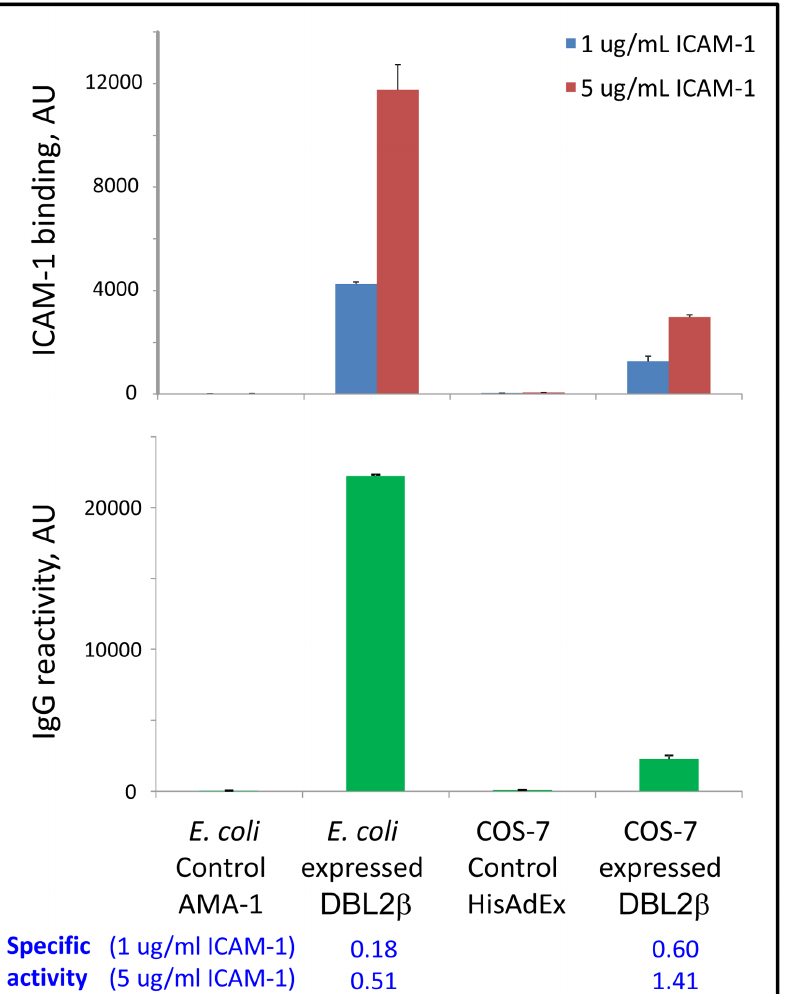
Figure 3. E.coli expressed/refolded PF11_0521 DBL2 domain binds ICAM-1 but has , 3 times lower specific activity than COS-7 expressed domain. Amount of protein on beads was measured by reactivity of rat plasma IgG raised against E. coli -expressed full-length DBL2 domain (in arbitrary units, AU). Error bars represent Standard Deviations. Dilution used (1:32000) is in the linear range of titration curve for these antibodies. Specific activity=AU(ICAM-1 binding)/AU(IgG